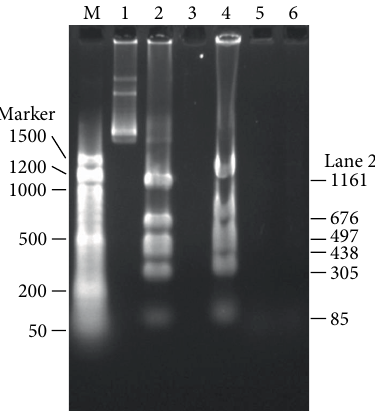
Figure 2: Electrophoresis of DNA samples. M: 50 bp DNA ladder; lane 1: pUC118 plasmid DNA; lane 2: cleaved plasmid DNA; lane 3: HA; lane 4: the mixture of HA and cleaved plasmid DNA; lane 5: